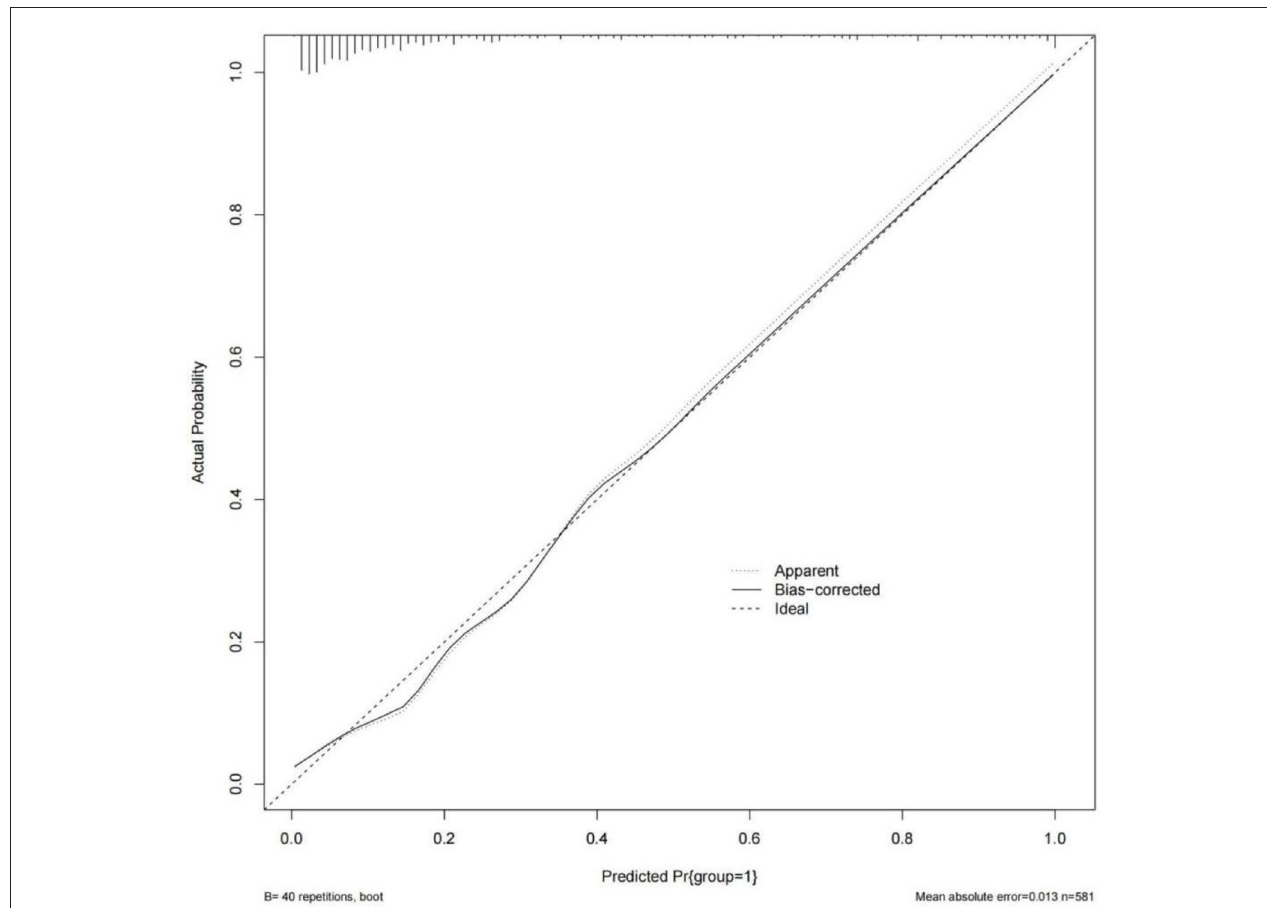
FIGURE 5 | Calibration curve of GDM observation probability and prediction probability.